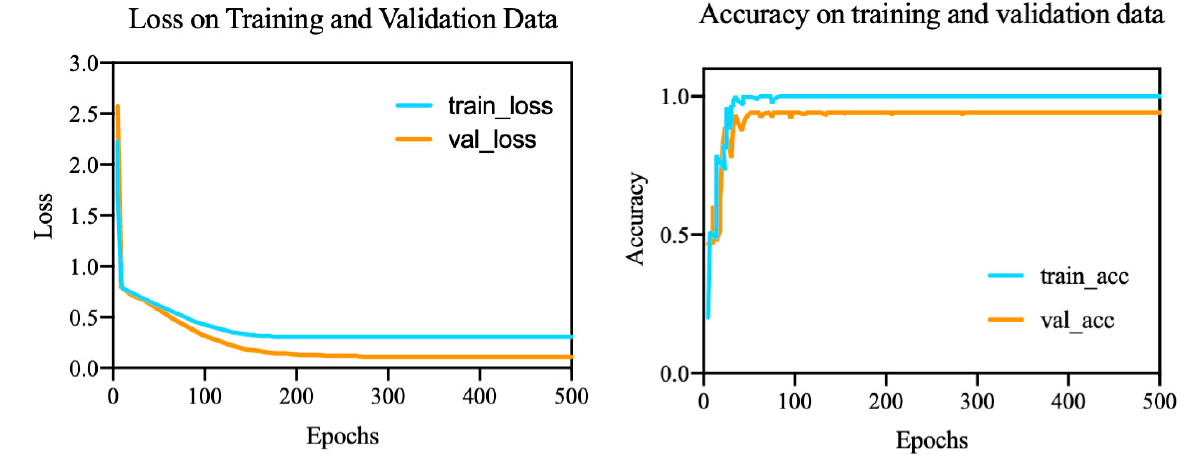
Figure 11. Loss and accuracy.